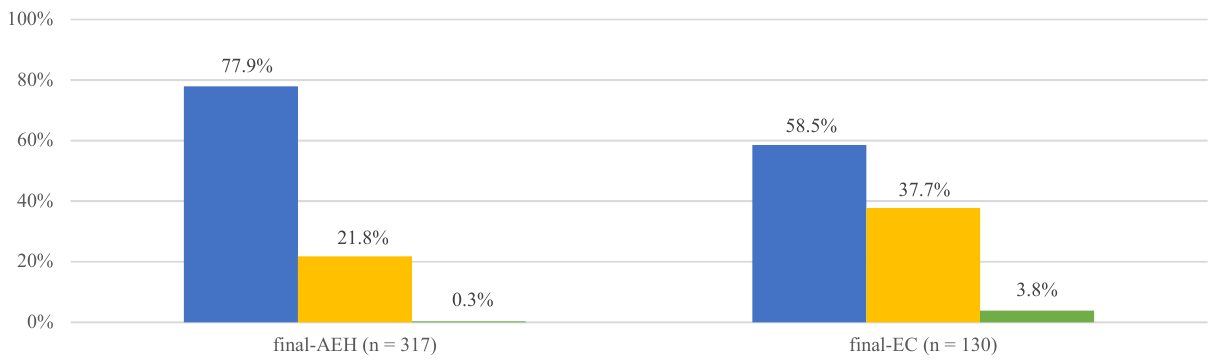
Figure 1. The distribution of final-AEH and final-EC patients diagnosed postoperatively in 3 sub- groups according to menopausal status and CA125 value preoperatively. Notes: According to menopause status and serum of CA125 level, patients were divided into three subgroups: “premeno- pausal status + CA125 <3 5 U/mL”, “either postmenopausal status or CA125 ≥ 35 U/mL” and “post- menopausal status + CA125 ≥ 35 U/mL”. Abbreviations: final-AEH, atypical endometrial hyper- plasia diagnosed by final histopathology; final-EC, endometrial cancer diagnosed by final histo- pathology; CA125, cancer antigen 125.